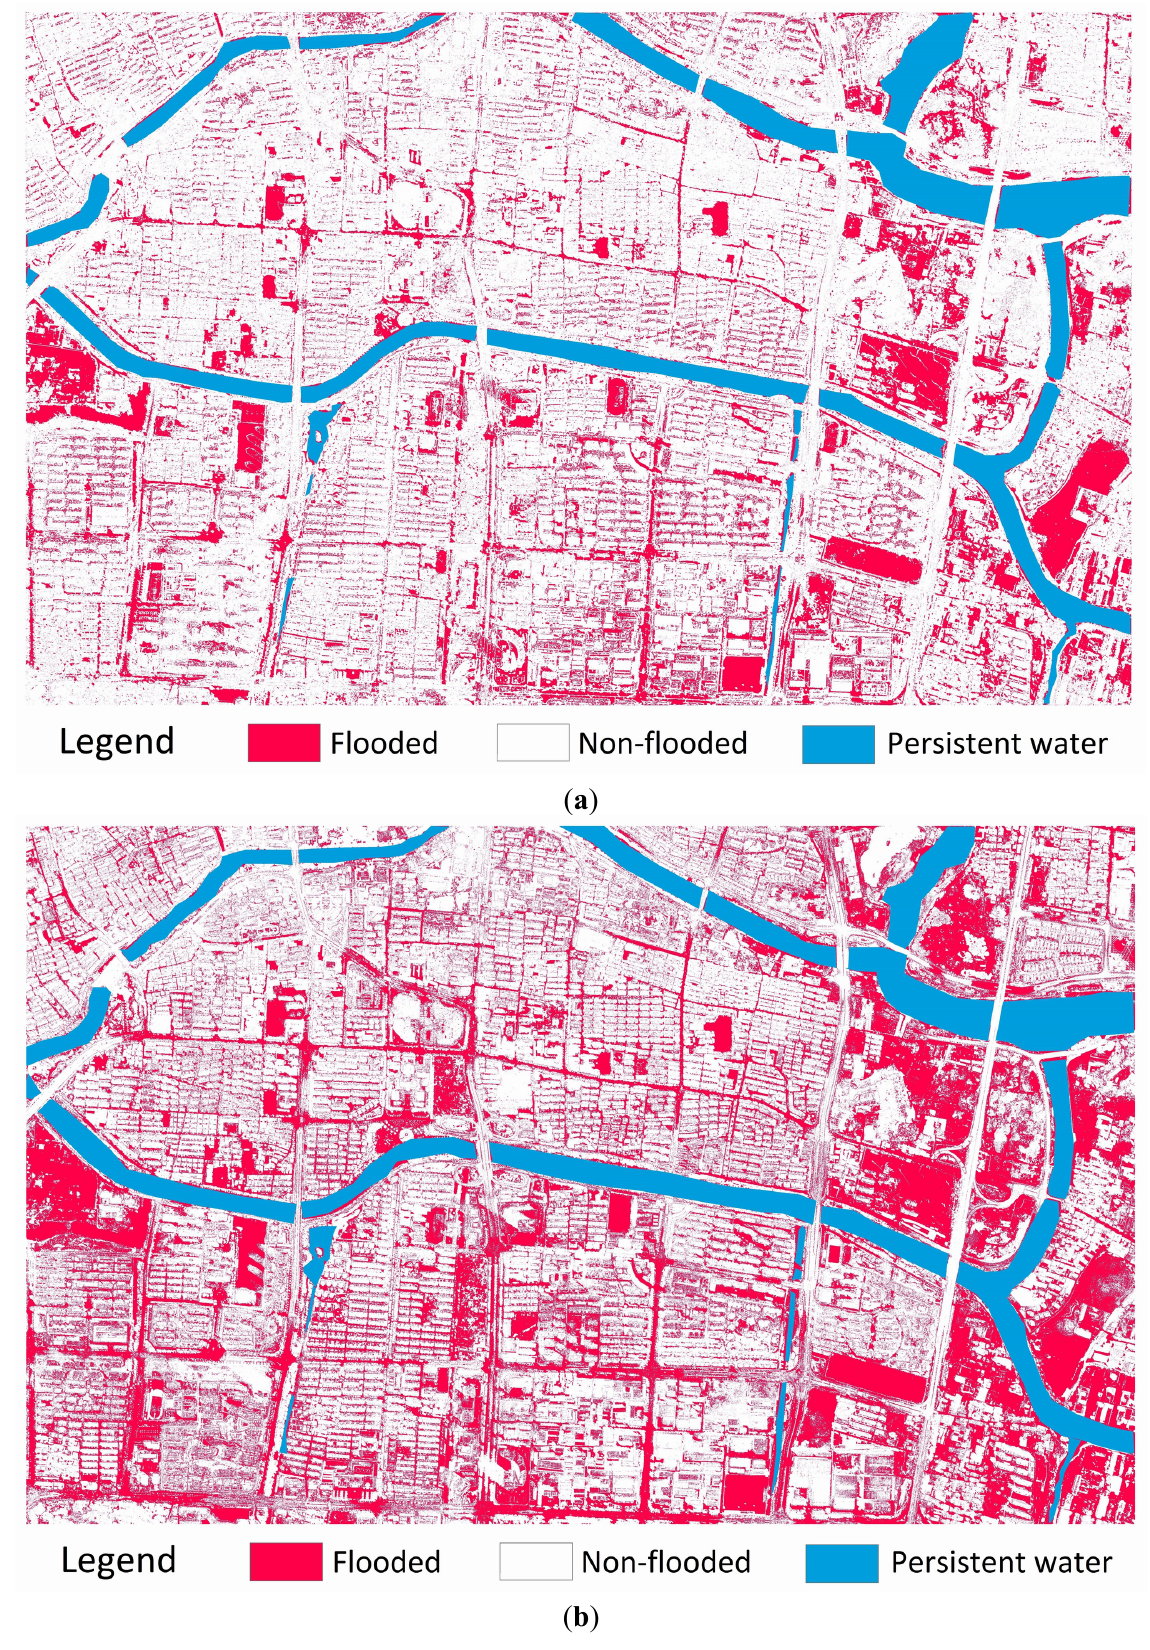
Figure 8. Flood mapping results for ( a ) RGB-only; ( b ) RGB +